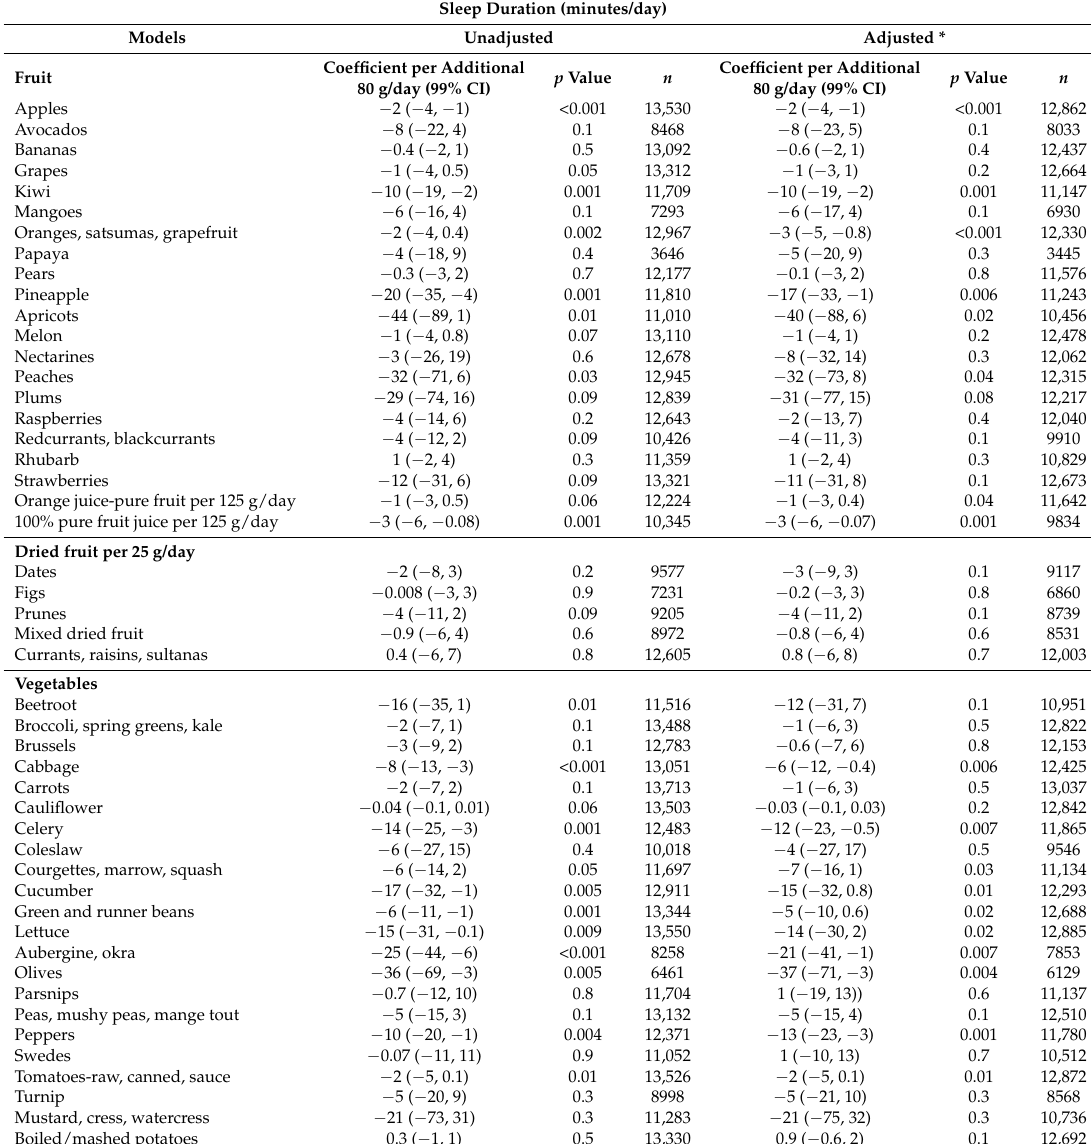
Table 2. The prospective associations between FV intakes and sleep duration of women from the